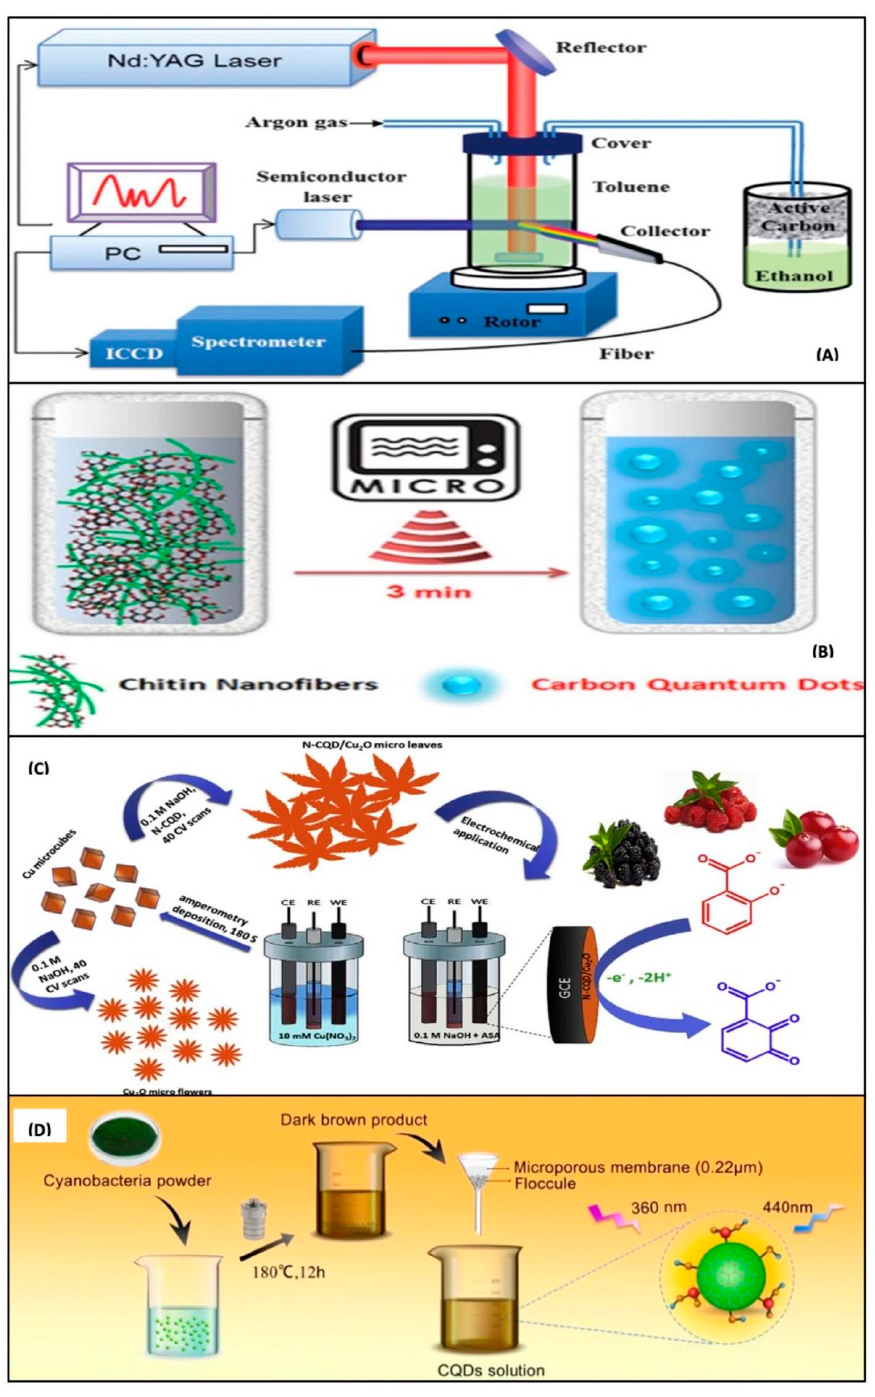
Figure 4. Synthetic approach for CQDs: ( A ) laser ablation method; ( B ) microwave method; ( C ) electrochemical method; and ( D ) hydrothermal method (Adapted from the Ref. [77] with the permission of nanomaterials).